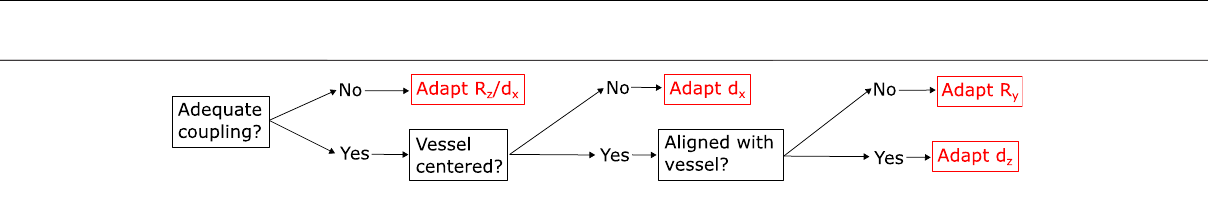
Frontiers in Robotics and AI |